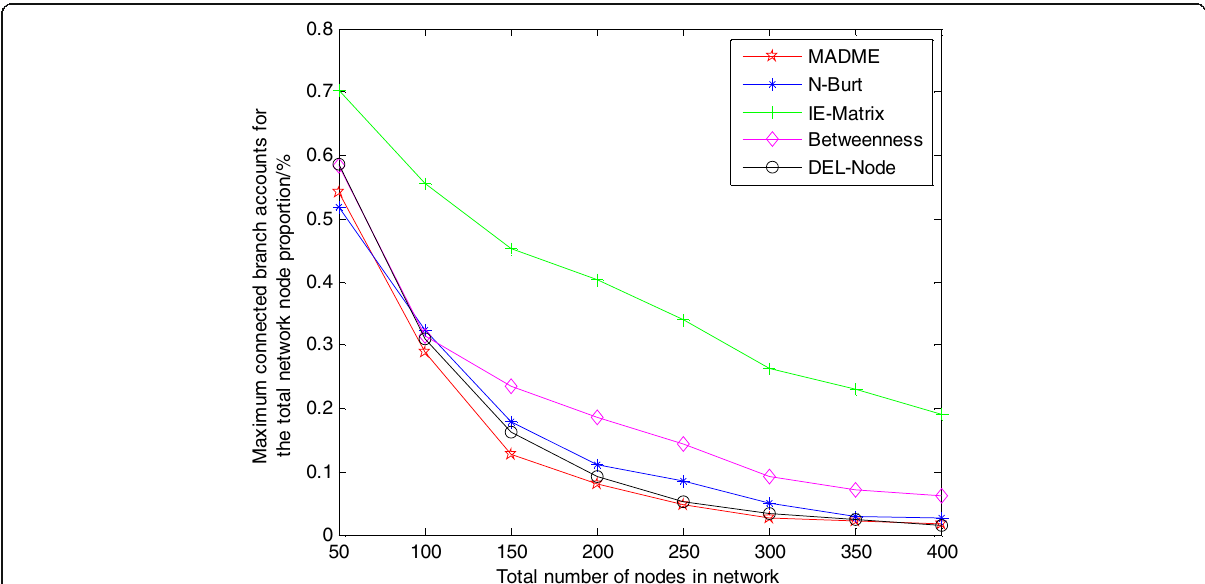
Fig. 7 Maximum connected branch proportion of the network after removing the key nodes under different network scales. For different network sizes, the maximum connected branch proportion of the network after removing the first 10% of the key nodes identified by the five methods is analyzed, i.e., MADME, N-Burt, IE-Matrix, betweenness, and DEL-Node